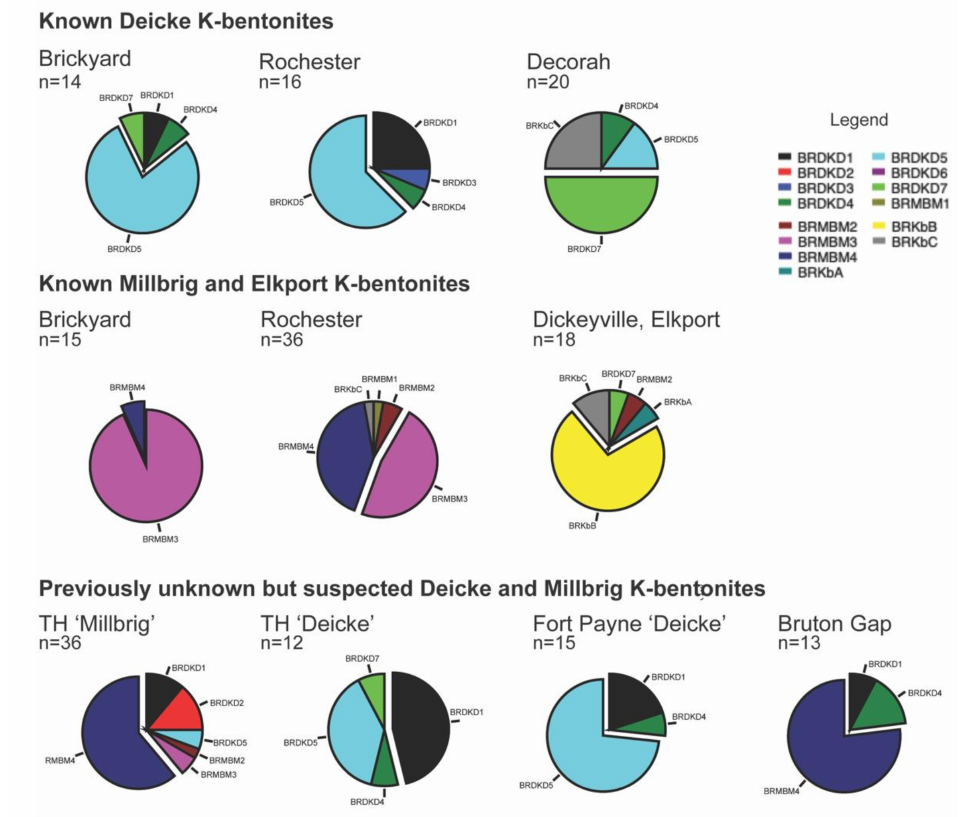
Figure 6. Identification results based on applying the Big-Ridge-Model to K-bentonite beds that had previously been identified as Deicke, Millbrig, and Elkport K-bentonites in the Upper Mississippi Valley and K-bentonite beds in the Southern Appalachians that had previously been interpreted as correlative to the K-bentonites in the Upper Mississippi Valley. ‘Brickyard’ is the informal field name of the exposure where the Deicke K-bentonite sample was collected in St. Paul, Minnesota; ‘TH’ is Tidwell Hollow,